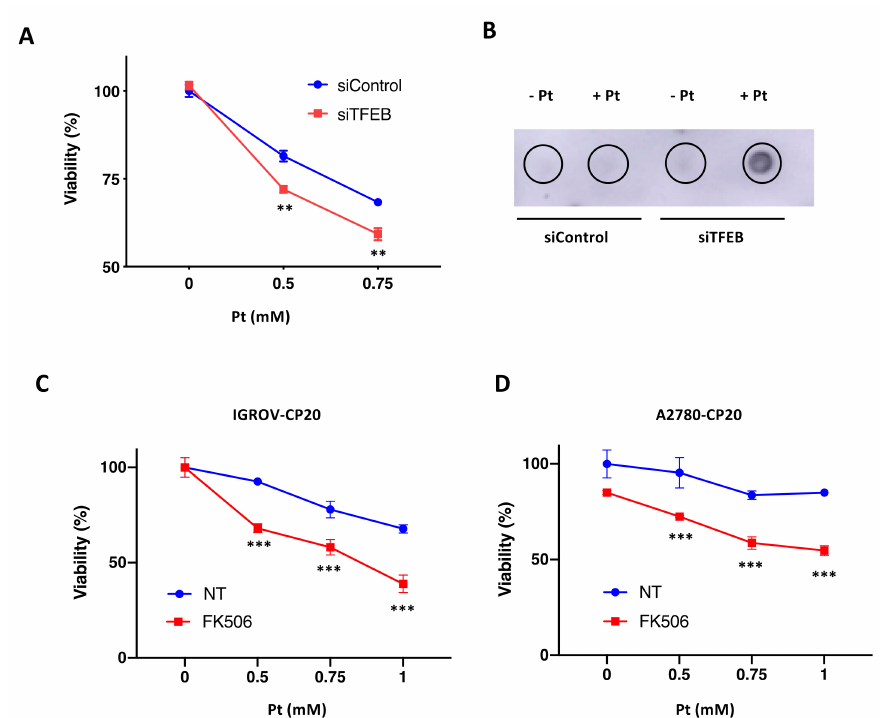
Figure 4. TFEB suppression promotes cisplatin toxicity in resistant ovarian cancer cells. ( A ) TFEB- silenced (siTFEB) and control (siControl) IGROV-CP20 cells were exposed to different concentrations of cisplatin (Pt) for 24 h and then subjected to MTT assay to evaluate their viability. Silencing of TFEB results in increased IGROV-CP20 cell mortality upon different Pt concentrations (**, p < 0.01, ANOVA; n = 3 experiments). ( B ) DNAs from TFEB-silenced (siTFEB) and control (siControl) IGROV-CP20 cells were isolated directly ( − Pt) or 24 h after treatment with 0.5 mM cisplatin (+Pt) and analyzed using dot blot with an antibody that recognizes Pt-DNA adducts. The analysis revealed an increased amount of DNA adducts in TFEB-depleted IGROV-CP20 cells. ( C , D ) IGROV-CP20 ( C ) and A2780-CP20 ( D ) resistant cells were treated with 10 µ M FK506 and then exposed to increasing concentrations of cisplatin (Pt). MTT assay shows that FK506 promoted Pt toxicity in both cell lines (***, p < 0.001, ANOVA; n = 3